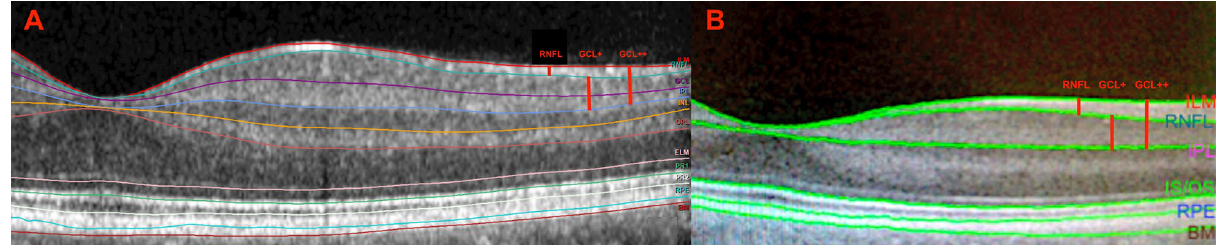
Figure 1. (Tomographic profile obtained by different OCT devices. ( A ) Tomographic image obtained by Spectralis SD-OCT and automatic segmentation was made by its software version 6.8.1.0. On the right margin are the abbreviations of all the layers of the automated macular segmentation provided by Spectralis SD-OCT software. The thickness of the RNFL, GCL+ and GCL++ protocols are described in the Materials and Methods section. Retinal nerve fiber layer thickness (RNFL) from the inner limiting membrane (ILM) line to the RNFL line. GCL+ thickness from the RNFL line to the inner plexiform layer (IPL) line and GCL++ thickness from the ILM line to the IPL line. GCL, ganglion cell layer; INL, inner nuclear layer; OPL, outer plexiform layer; ELM, external limiting membrane; PR1, photoreceptor inner segments; PR2, photoreceptor outer segments; RPE, retinal pigment epithelium; BM, Bruch membrane. ( B ) Tomographic image obtained by DRI Triton SS-OCT and automatic segmentation was made by its IMAGEnet 6 Version software 1.221.14101 2014 Topcon Corporation. On the right margin are the layer abbreviations of the automated macular segmentation provided by DRI Triton SS-OCT software. The thickness of the RNFL, GCL+ and GCL++ protocols are described in the Materials and Methods section. Retinal nerve fiber layer thickness (RNFL) from the inner limiting membrane (ILM) line to the RNFL line. GCL+ thickness from the RNFL line to the inner plexiform layer (IPL) line and GCL++ thickness from the ILM line to the IPL line. IS/OS, inner/outer segments; RPE, retinal pigment epithelium; BM, Bruch